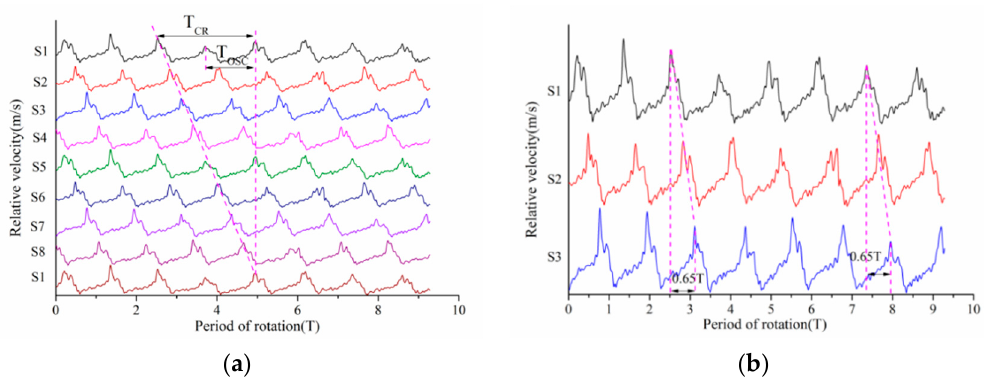
Figure 17. Relative velocity curve of the monitoring point when the flowrate is 0.6 kg/s: ( a ) the curve of the relative velocity at 8 points; ( b ) the curve of the relative velocity at 3 adjacent points.